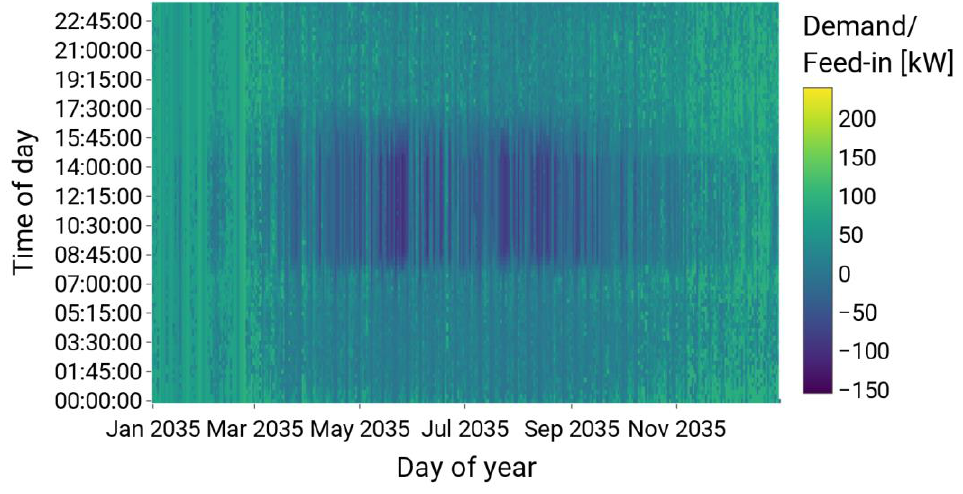
Figure A3. Heatmap of the electric demand (positive values) and feed-in (negative values) for the feeder fee scenario, the scenario year 2035 and the rural grid.